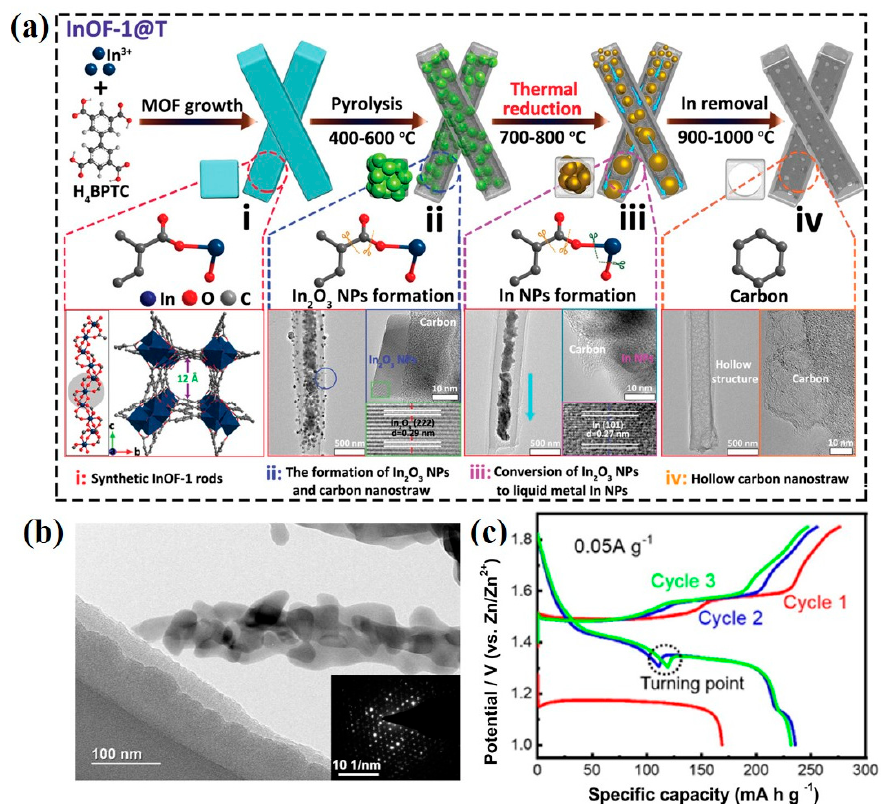
Figure 4. ( a ) Schematic illustration to obtain InOF-1-derived hierarchically porous HCNS with their di ff erentiated carbonized stages at di ff erent temperatures: ( ⅰ ) Synthetic InOF-1 rods; ( ⅱ ) The for- their differentiated carbonized stages at different temperatures: ( i ) Synthetic InOF-1 rods; ( ii ) The mation of In 2 O 3 NPs and carbon nanostraw; ( ⅲ ) Conversion of In 2 O 3 NPs to liquid metal In NPs; ( ⅳ ) formation of In 2 O 3 NPs and carbon nanostraw; ( iii ) Conversion of In 2 O 3 NPs to liquid metal In Hollow carbon nanostraw. ( b ) TEM image of as-prepared α -Mn 2 O 3 (the inset is electron di ff raction NPs; ( iv ) Hollow carbon nanostraw [65]. Copyright 2022, John Wiley and Sons. ( b ) TEM image pa tt ern). ( c ) Capacity-voltage pro fi les of α -Mn 2 O 3 at 0.05 A g − 1 . of as-prepared α -Mn 2 O 3 (the inset is electron diffraction pattern). ( c ) Capacity-voltage profiles of − 1 [69]. Copyright 2021, α -Mn 2 O 3 at 0.05 A g